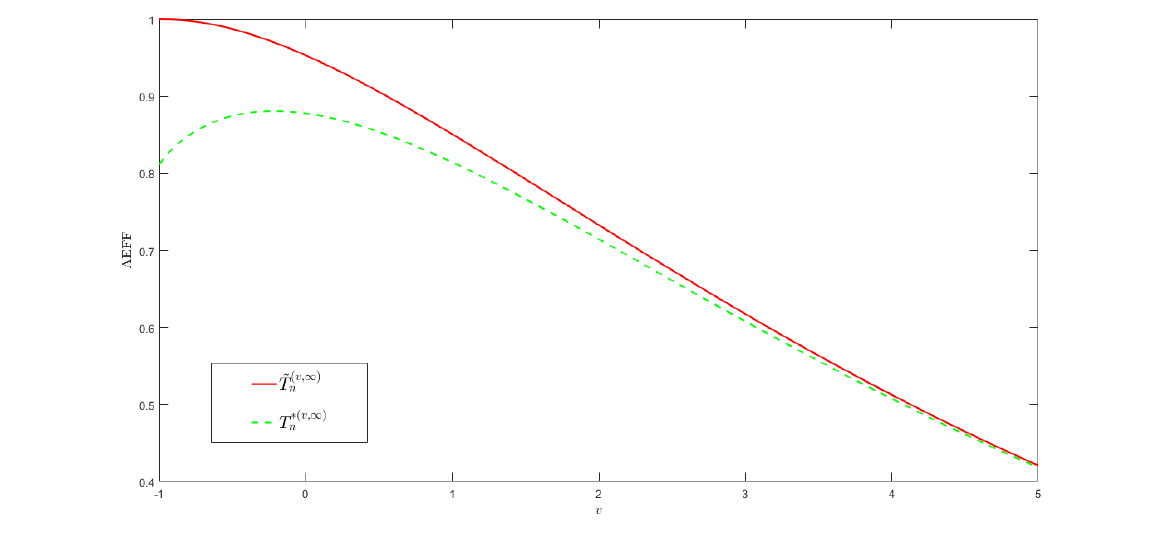
( v , ∞ ) ∗ ( v , ∞ ) n and T n compared to the MLE